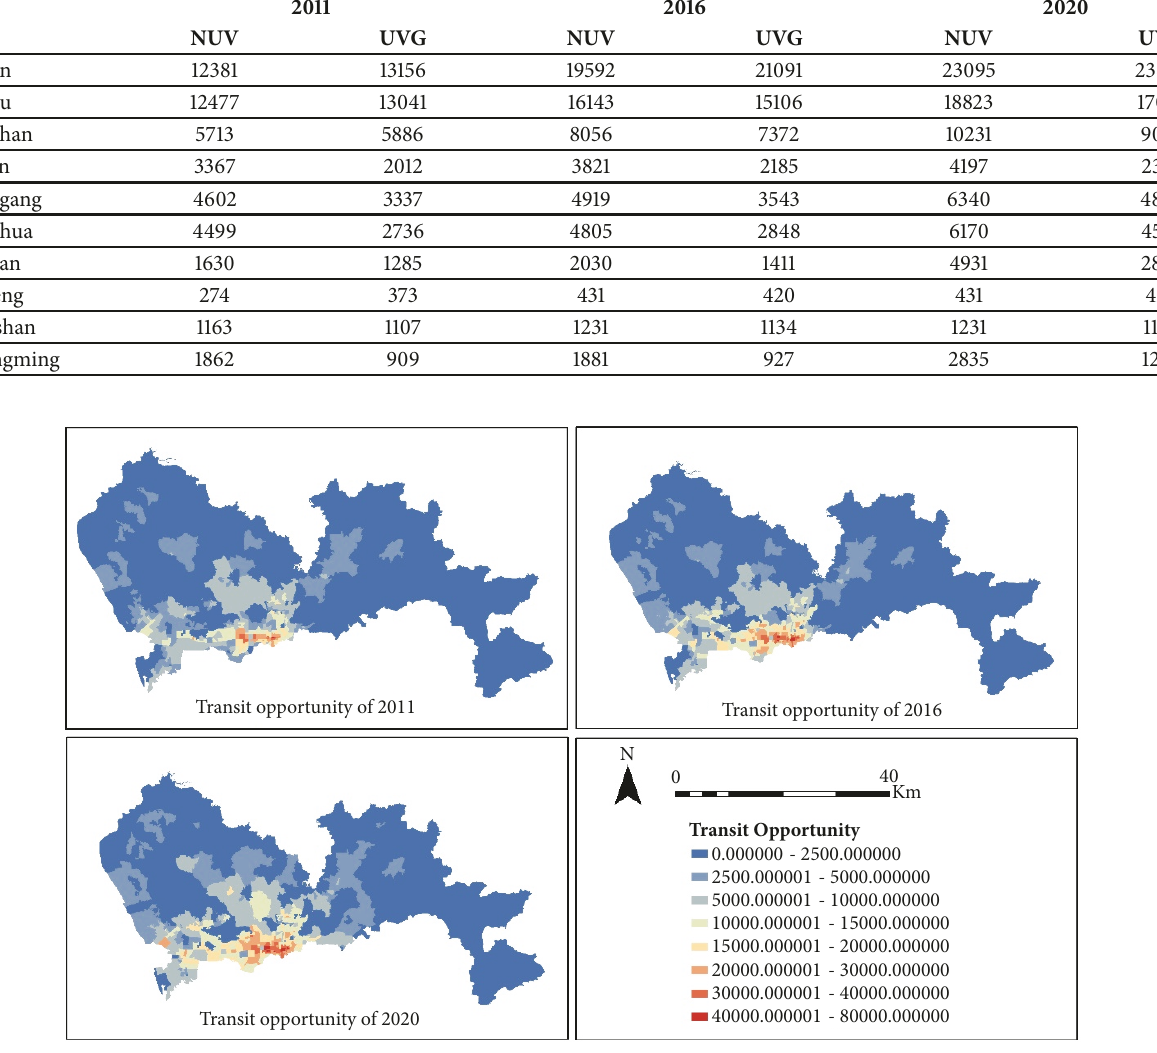
Figure 3: Maps of transit opportunity in three